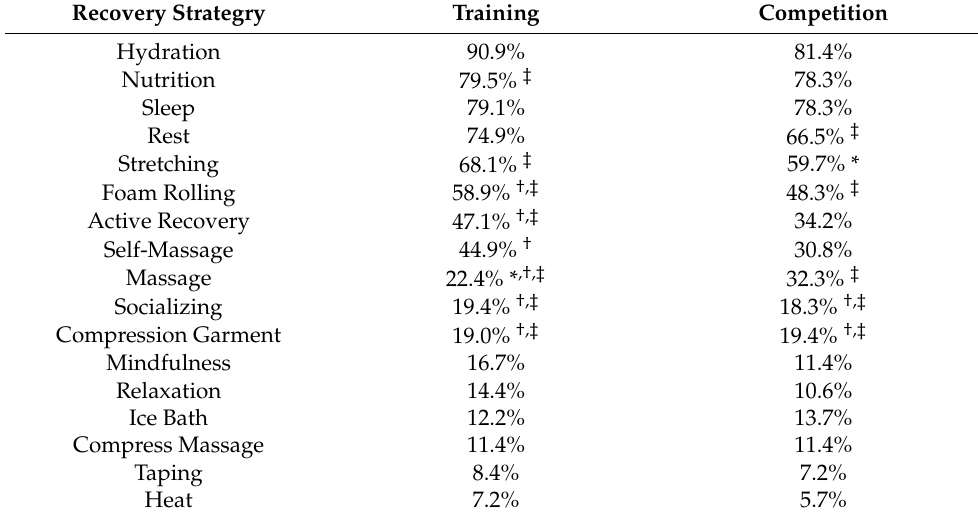
Table 2. Use of recovery strategy